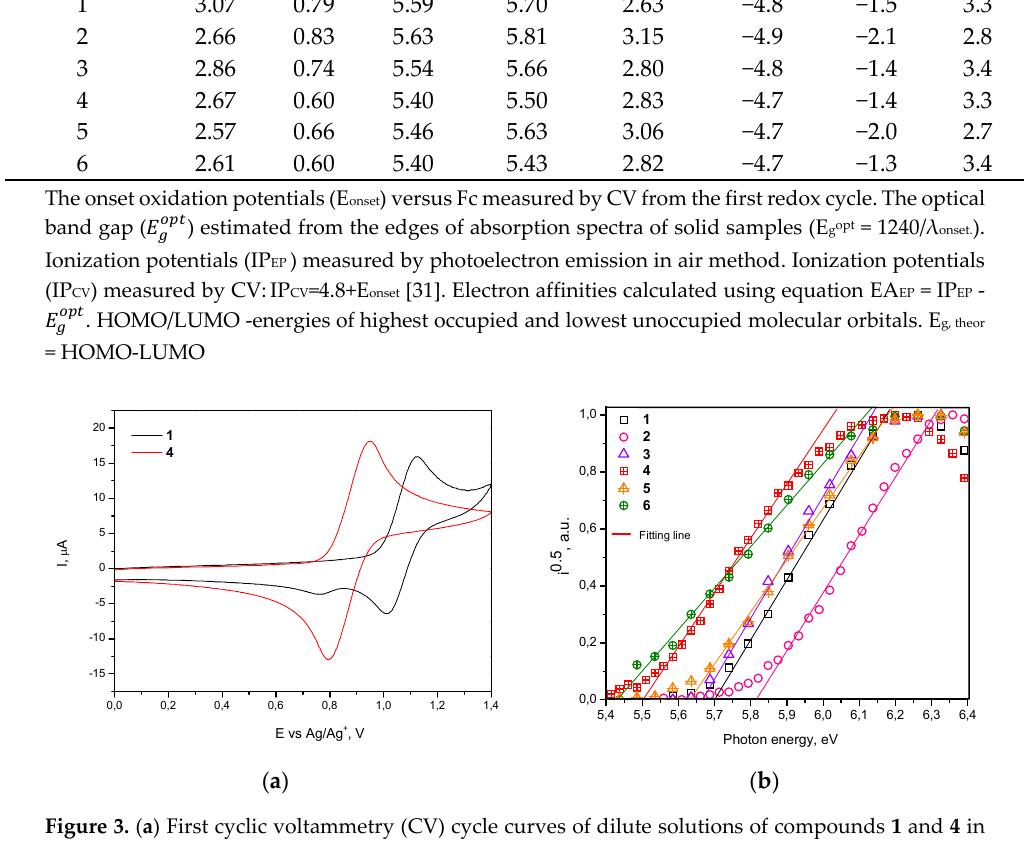
Table 2. Electrochemical, photoelectrical, and optical characteristics of compounds 1 – 6 . Compound 𝑬 𝒈𝒐𝒑𝒕 , eV